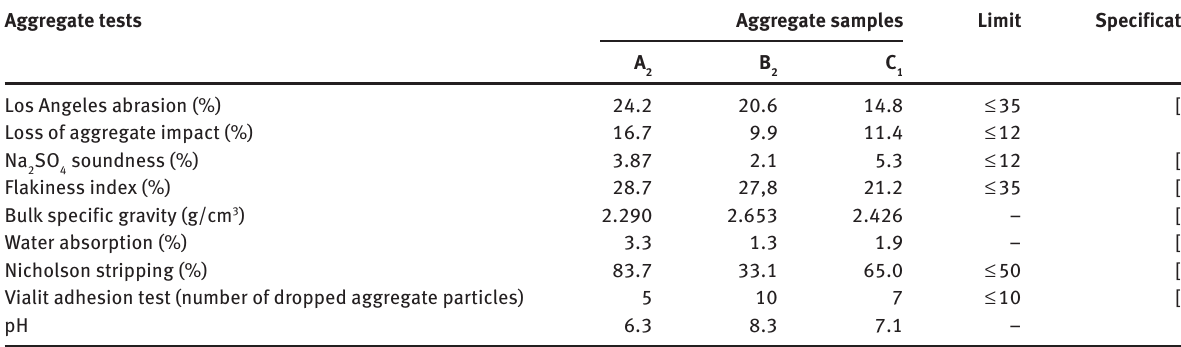
Table 3: Aggregate characteristics used in test roads.